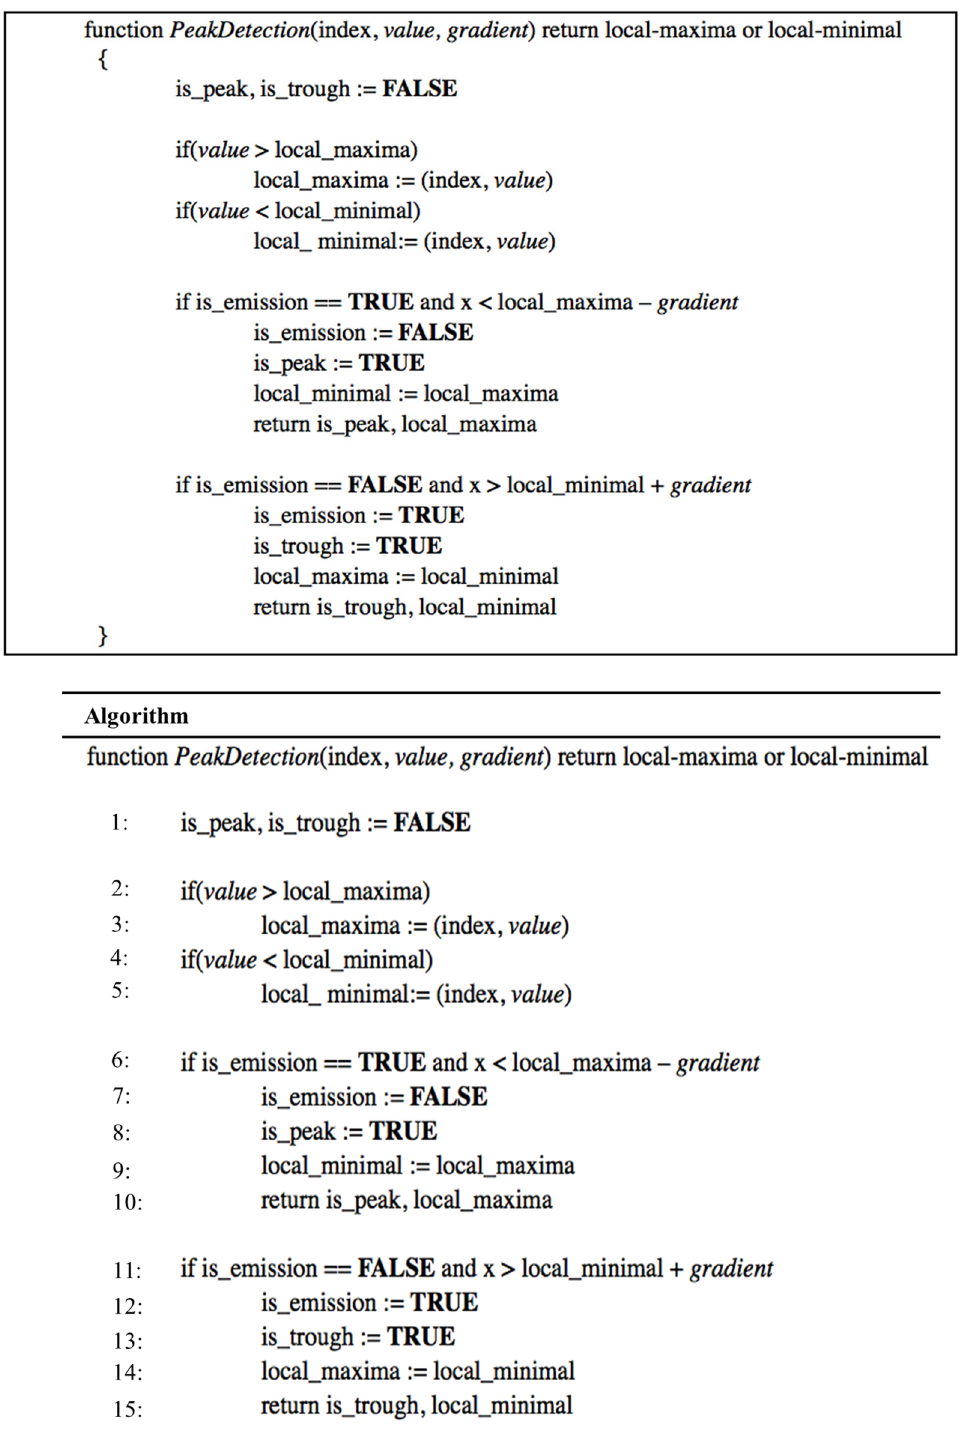
Figure 7. Pseudocode of the peak detection algorithm.